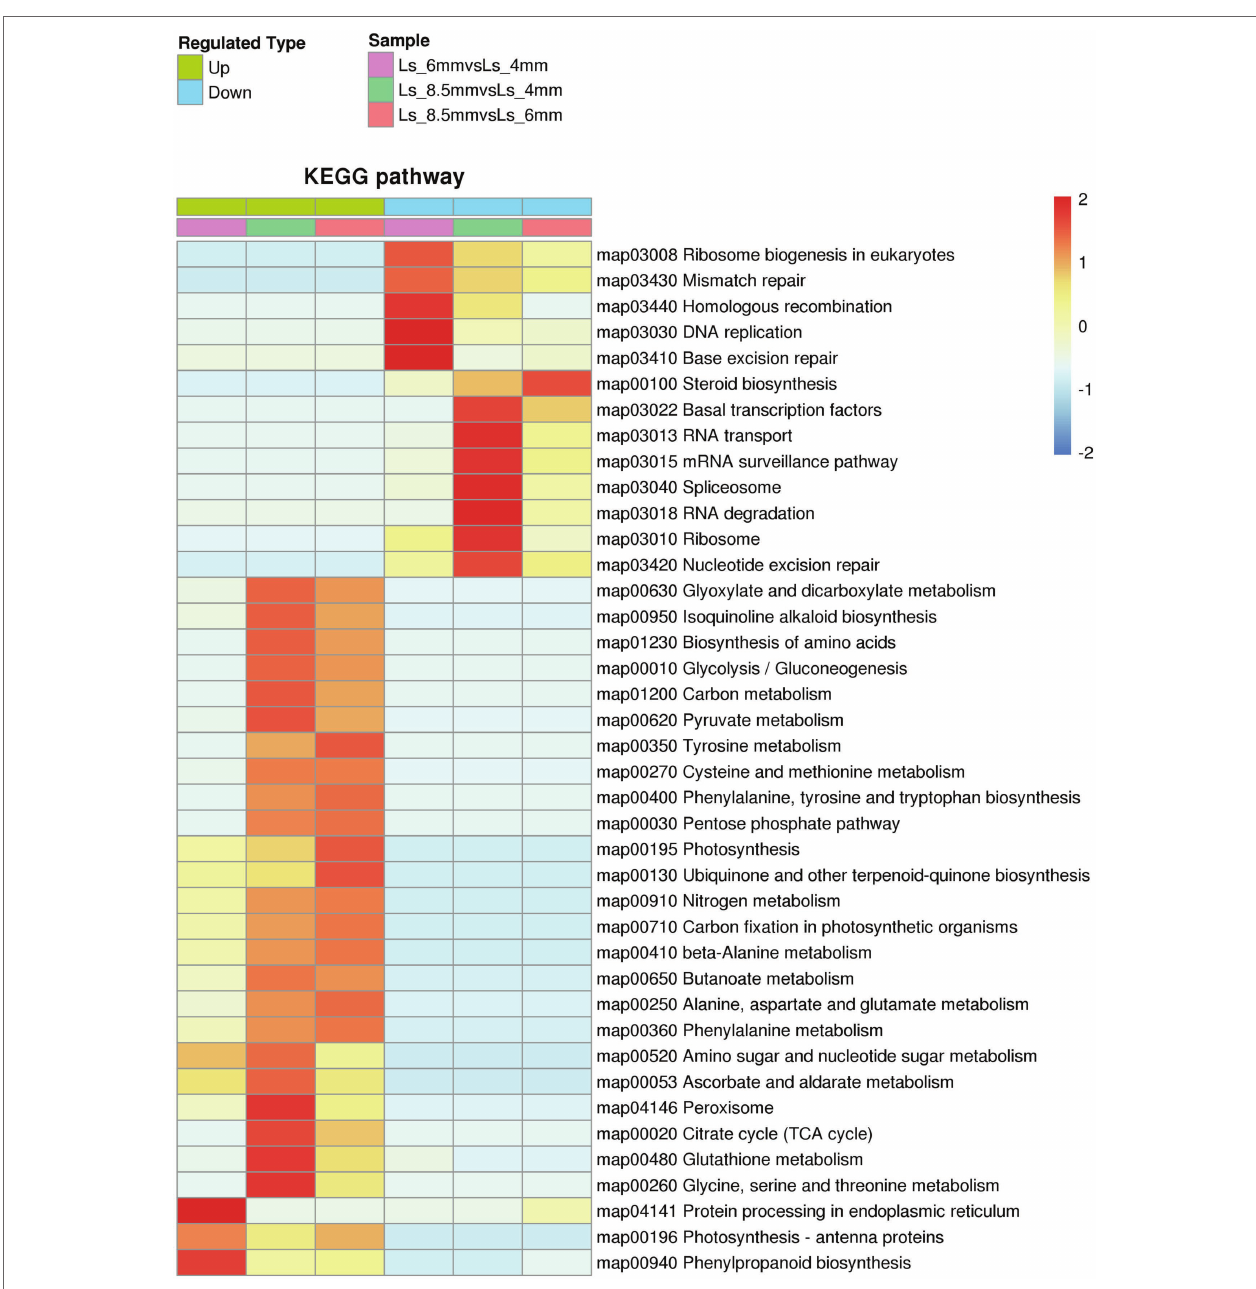
FIGURE 7 | Kyoto Encyclopedia of Genes and Genomes pathways significantly enriched in sets of DEPs from three spikelet developmental stages. The enriched pathways included metabolic pathways by which fatty acids are converted to